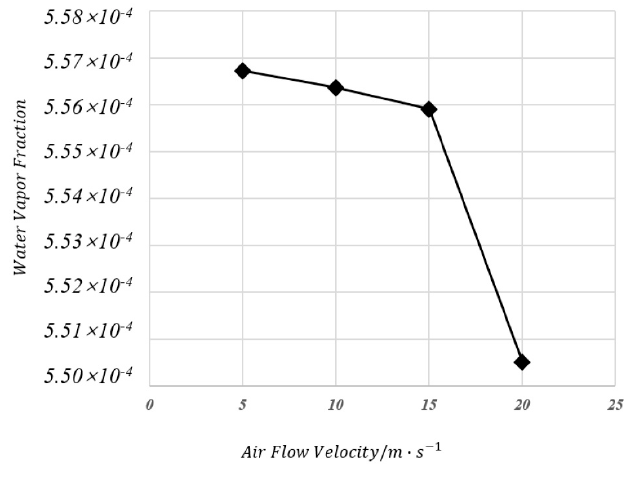
Figure 3. Water vapor mass fraction and relative humidity at the outlet of humidifier at different inlet gas velocity: ( a ) The inlet air velocity is 5 m ∙ s ‐ 1 ; ( b ) the inlet air velocity is 10 m ∙ s ‐ 1 , ( c ) the inlet air